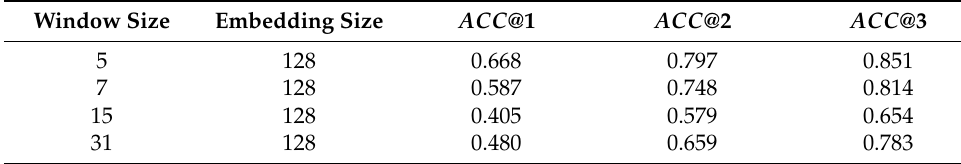
Table A4. Results for the best LBERT model with different window sizes. Window Size